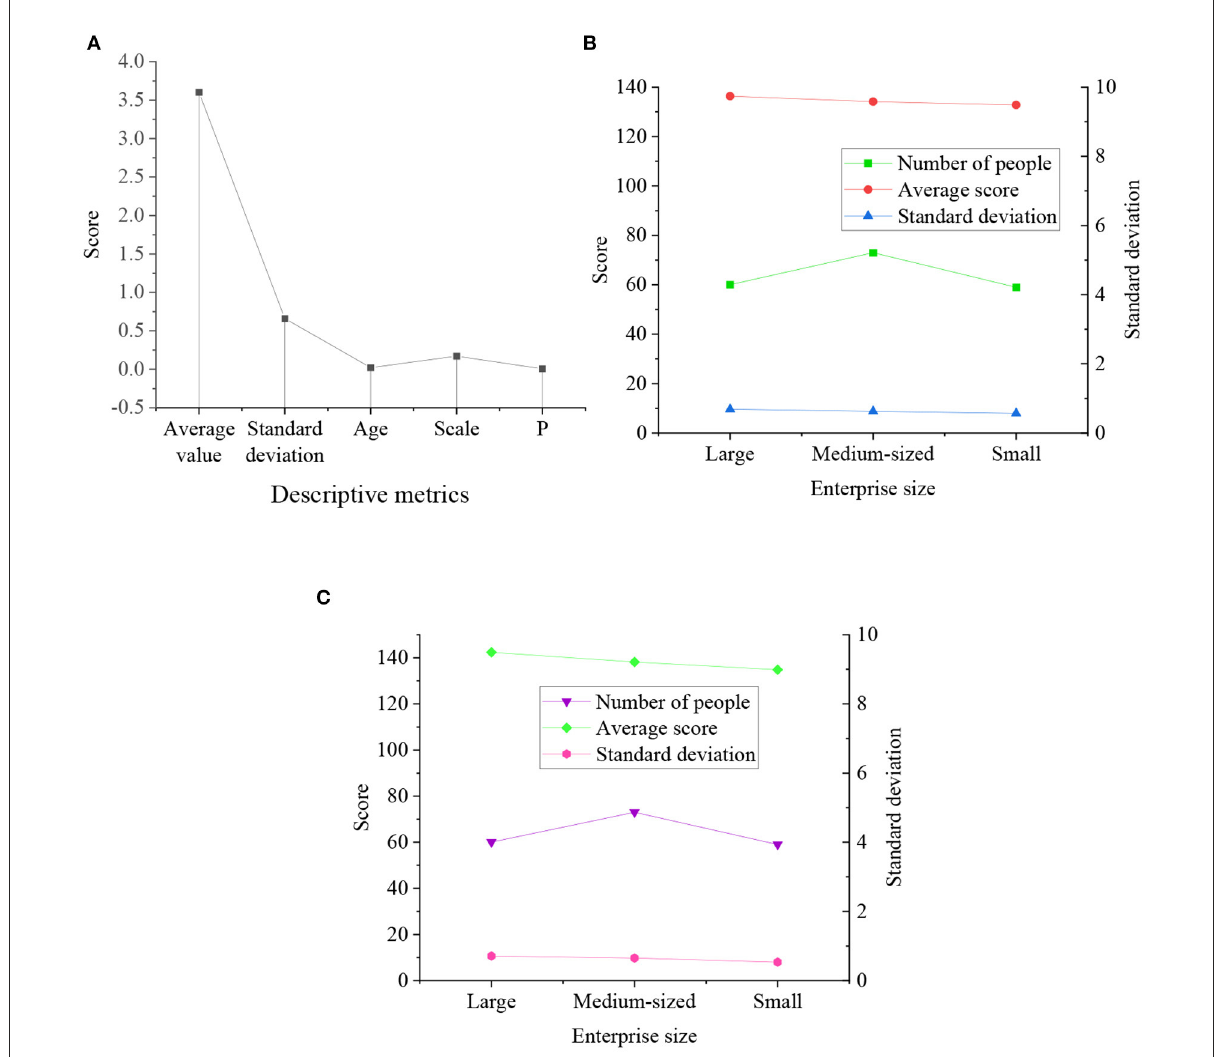
FIGURE8 Results of the relationship between ES and ED (A) Descriptive statistical results; (B) Statistical results of ES of enterprises of different sizes; (C) Statistical results of the development of enterprises of different